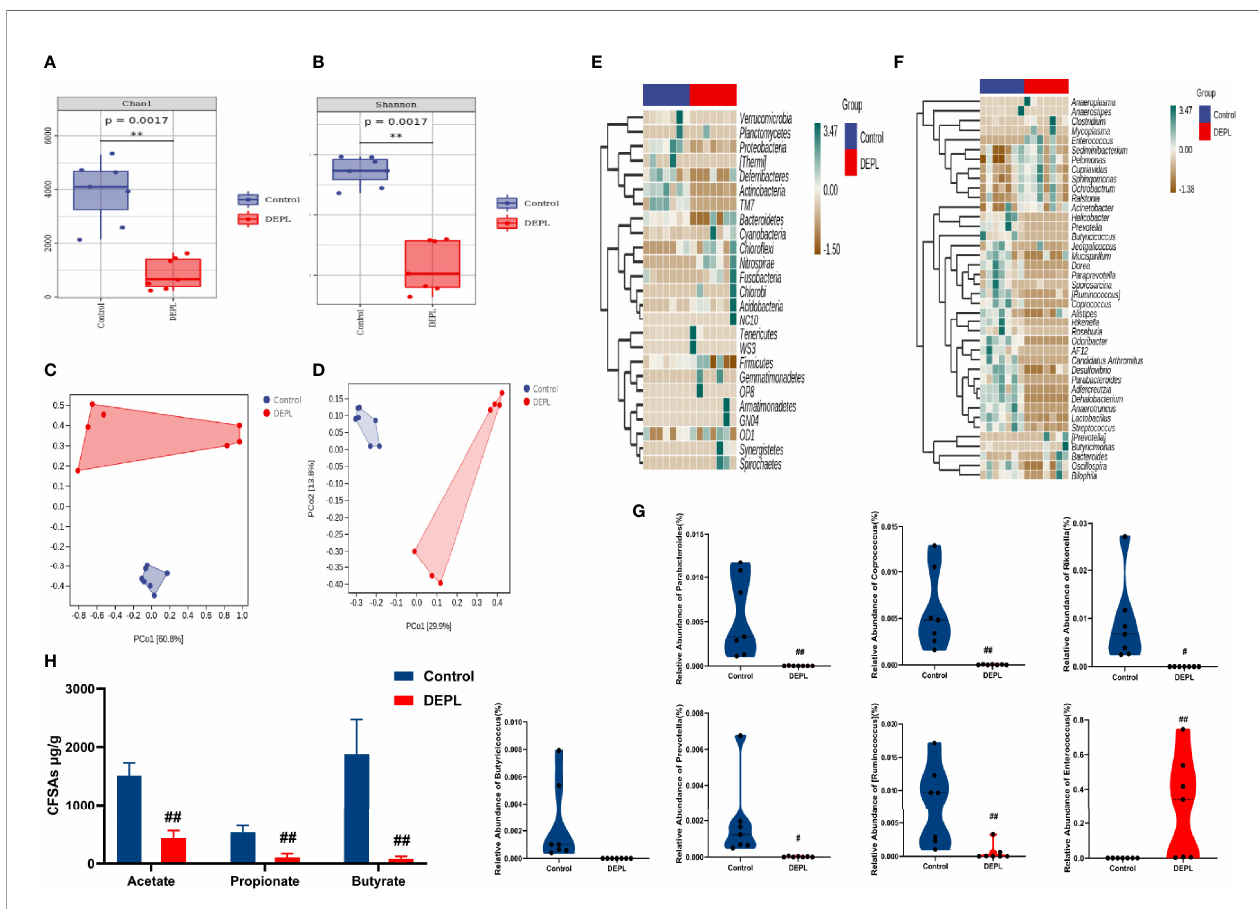
FIGURE 4 | Alpha diversity metrics were compared between Control and gut microbiota-depleted mice using (A) Chao 1 indices (B) Shannon indices, and (C, D) weighted and unweighted UniFrac distance-based PCoA. (E) Relative fecal bacterial abundance percentages of top 40 phylum and (F) top 40 genus. (G) Box chart of genera showing signi fi cant relative variations in bacterial abundance percentages at the genus level. (H) Levels of SCFAs (acetate, propionate, and butyrate) in mouse feces. Data are presented as the mean ± SD for each group (n = 7), # p < 0.05, ## p < 0.01, ** p < 0.01 versus